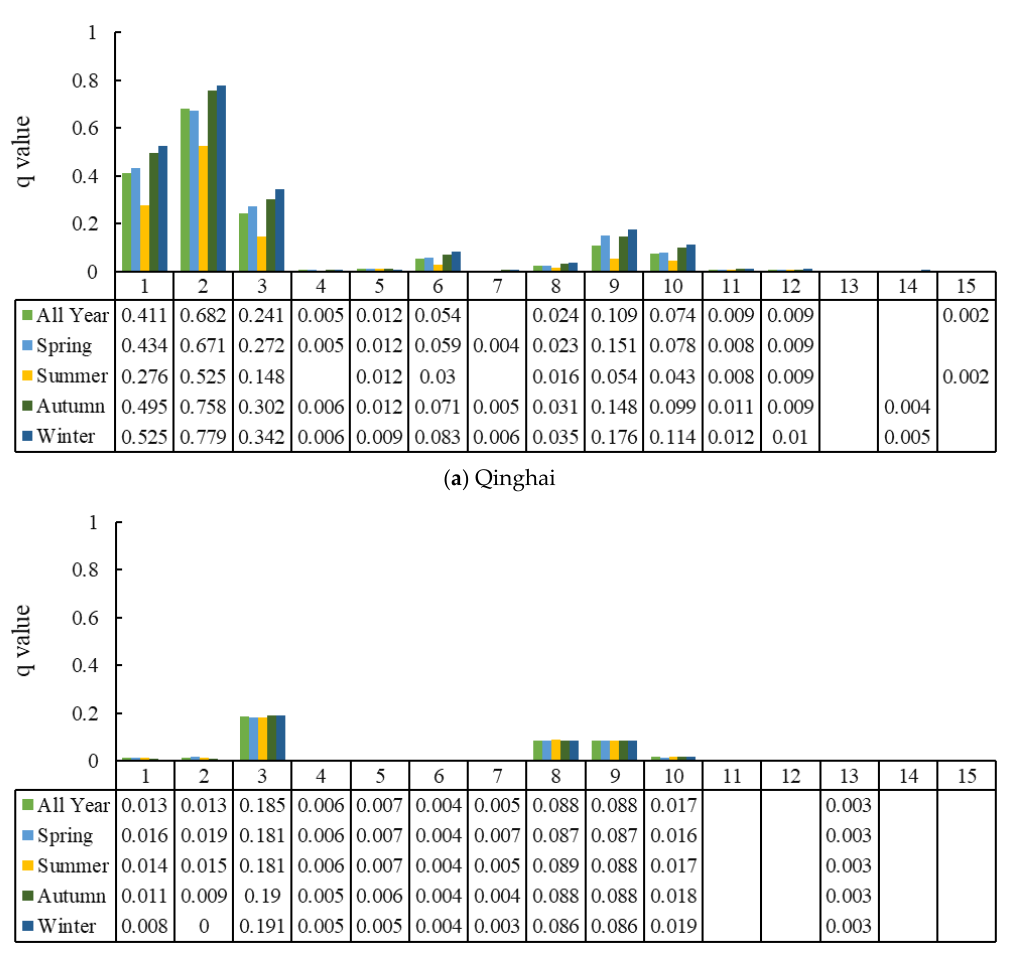
Figure 5. q -Statistics of influential factors in Qinghai and Tibet (1. tourist attractions; 2. hotels; 3. road network density; 4. distance to airport; 5. altitude; 6. population density; 7. urbanization rate; 8. regional GDP; area proportion: 9. urban, 10. rural, 11. forest, 12. wetland, 13. desert, 14. grassland, 15. glacier; Null: not statistically